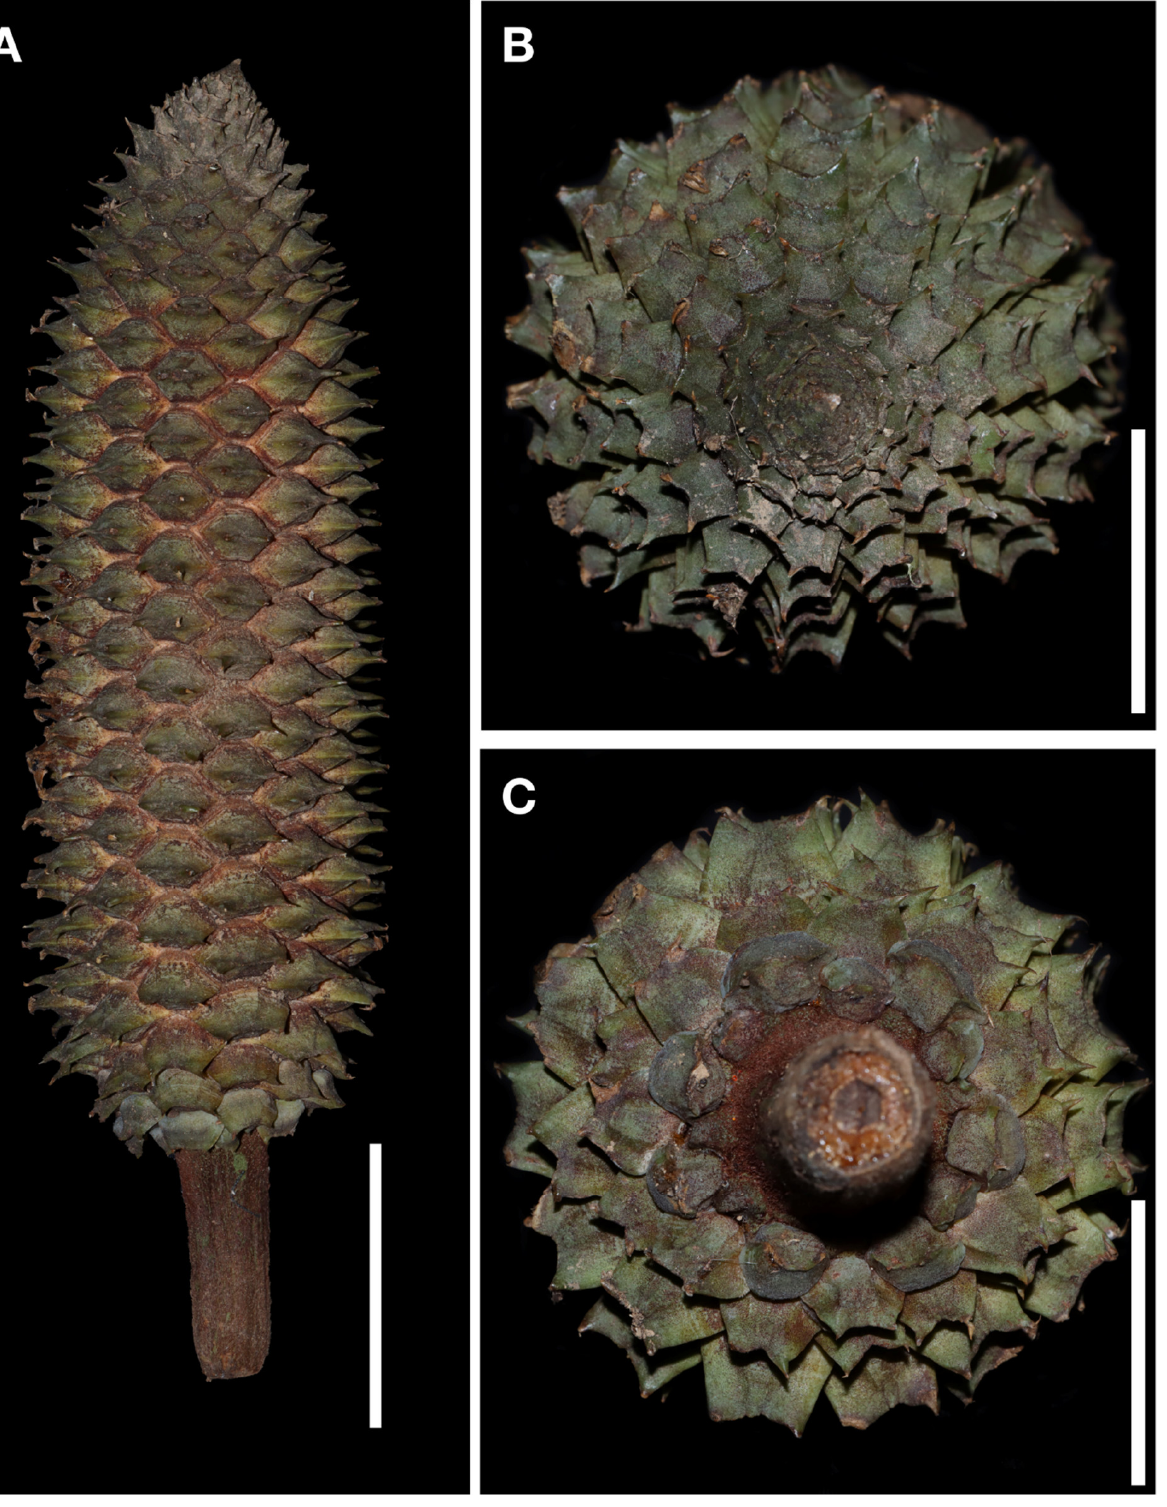
Figure 6. Megastrobilus (seed cone) of Ceratozamia schiblii . ( A ) Lateral view (scale = 10 cm); ( B ) view from above (scale = 5 cm), ( C ) view from below (scale = 5 cm). Photos by José García González.